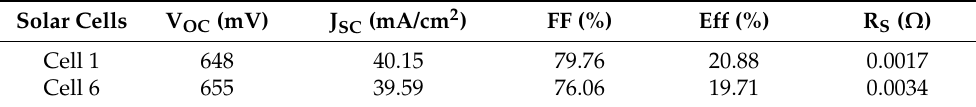
Table 1. The electrical characteristics of the solar cells under 1 sun light illumination. Solar Cells